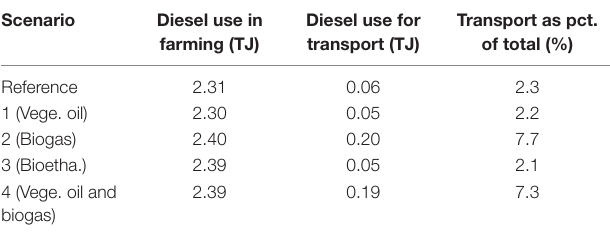
TaBle 5 | annual diesel use for farming and transportation for the entire system of 1000 ha for each scenario.